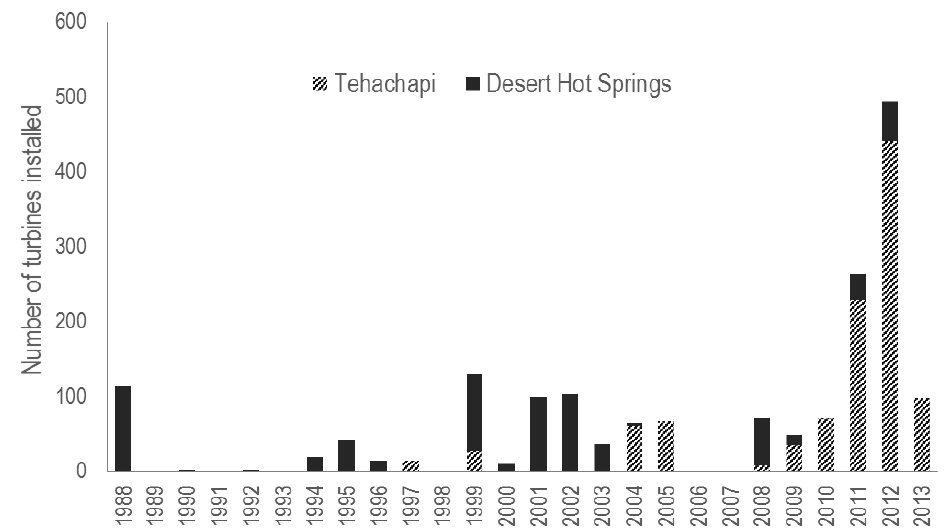
Figure 2. Number of turbines installed per year between 1988 and 2013 in the Tehachapi and Desert Hot Springs study